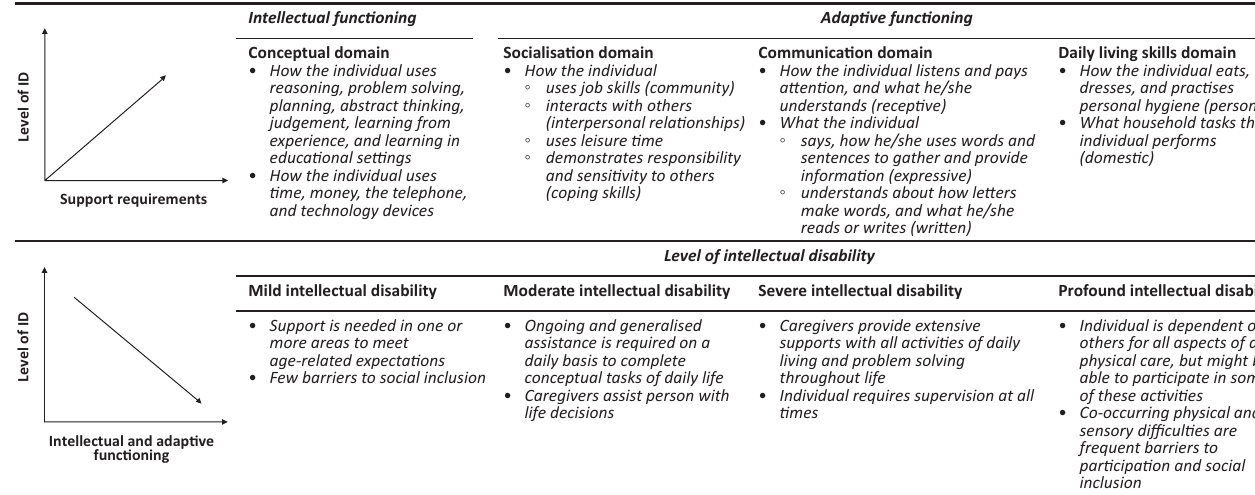
FIGURE 1: Continuum of support needs according to severity of intellectual